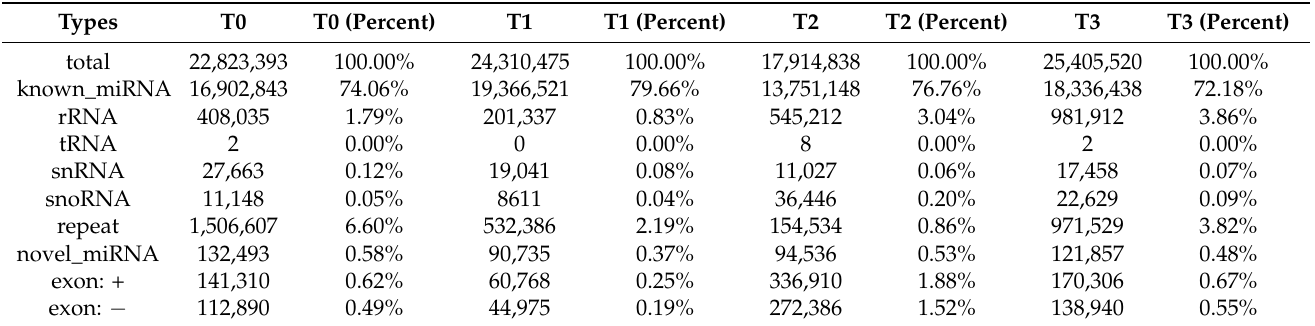
Table 4. Number of reads matched to various types of